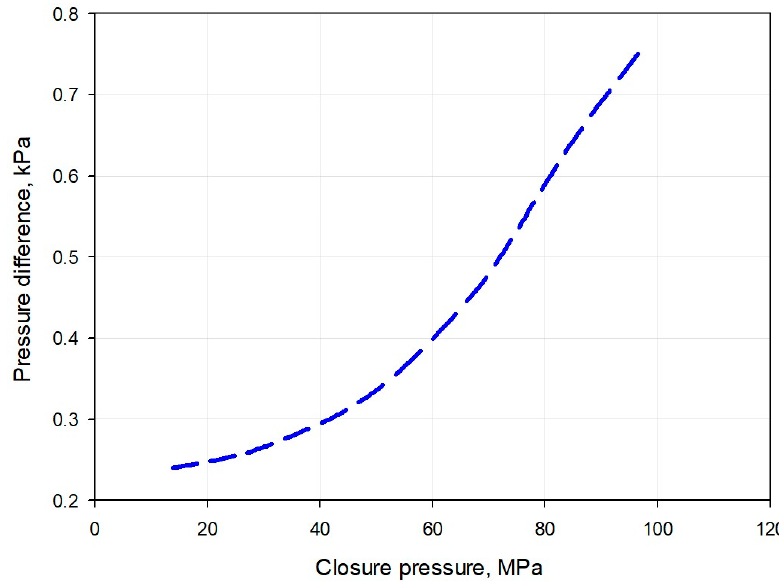
Figure 6. Pressure difference variation with the increase in closure pressure.